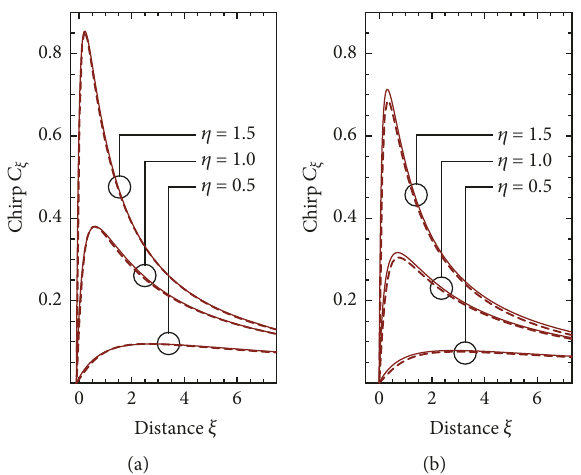
Figure 3: Chirp evolution for 𝜂 = 0.5 (bottom trace) to 𝜂 = 1.5 (top trace) in increments of 0.5 . Solid curves represent the approximation (15); dashed curves are numerical data. (a) 𝑁 = 0.001 approximates linear propagation. (b) 𝑁 = 0.5 represents the most extreme case considered here.